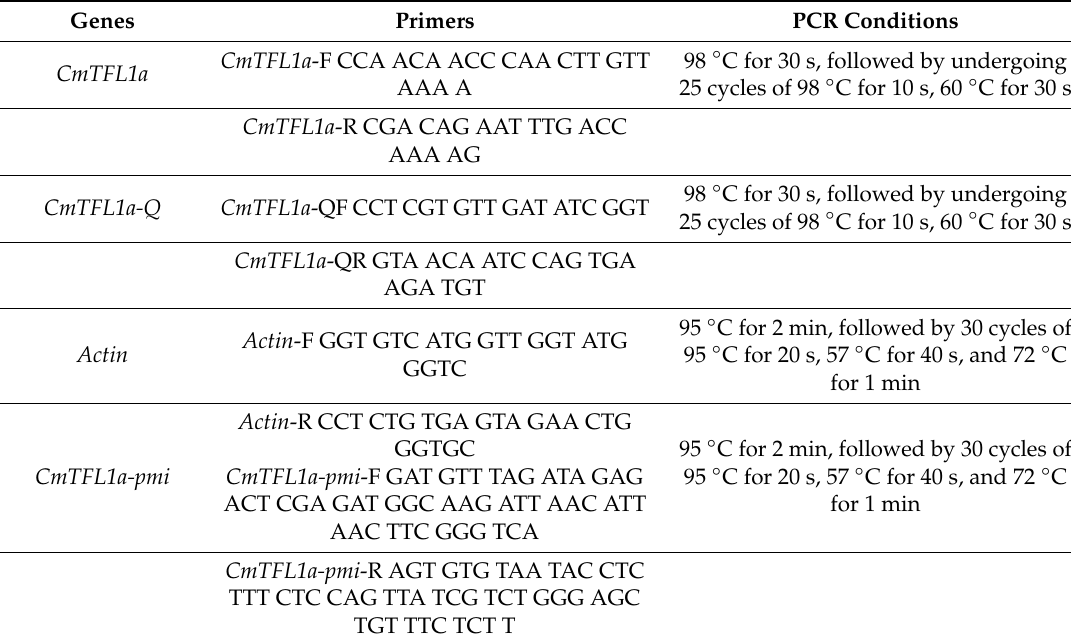
Table 2. Primers and polymerase chain reaction (PCR) parameters used for the current